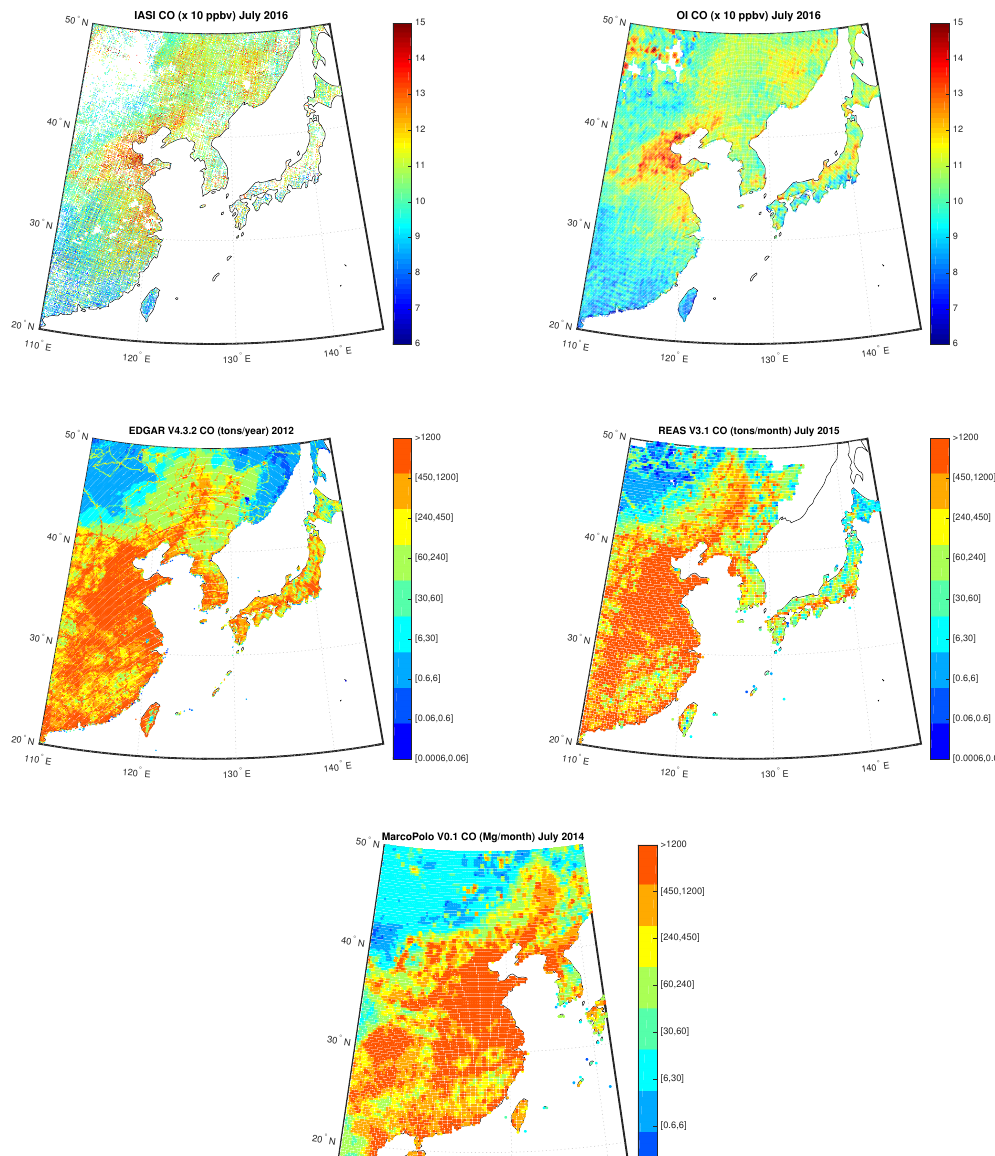
Figure 15. First row: IASI and OI CO over China for the month July 2016; Second Row: EDGAR V4.3.2 CO for the year 2012 and REAS V3.1 CO for the month of July 2015; Third Row: MarcoPolo v0.1 CO for the month of July